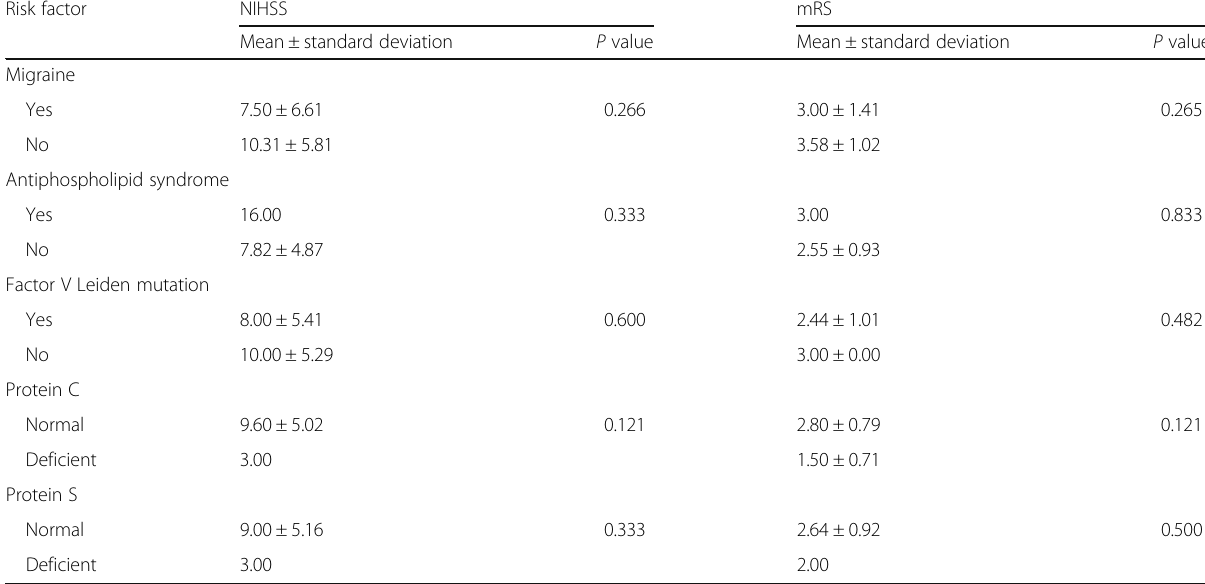
Table 7 Relation between potentially modifiable risk factors and ischemic stroke severity and disability at presentation using NIHSS and mRS